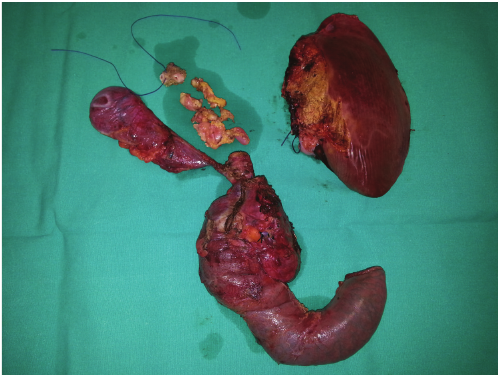
Figure 3: Pancreaticoduodenectomy material, high hilar resection specimens, and left lobe of the